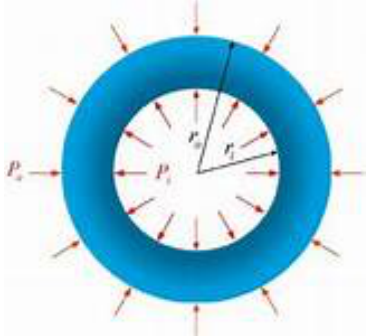
Figure 1: Hollow spherical